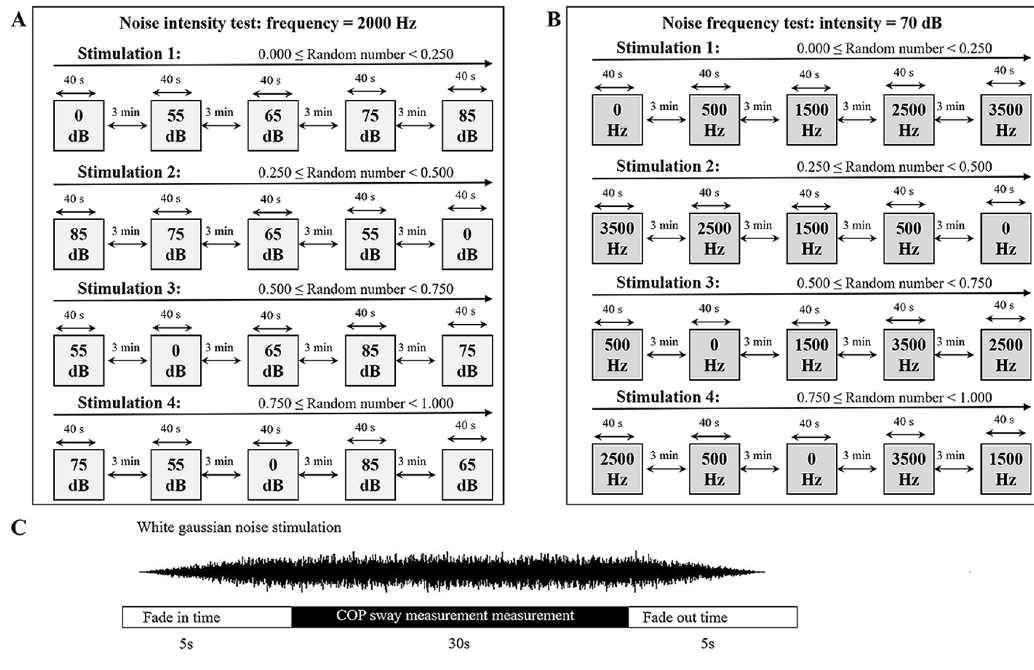
Figure 5. Diagram of the experimental protocol. ( A ) The stimulation blocks in noise intensity test; The stimulation frequency was set to 2000 Hz. Four stimulation blocks with different intensity sequence were previously defined. The stimulation block undergone by a participant was determined by the random number he/she obtained. ( B ) The stimulation blocks in noise frequency test; The stimulation intensity was set to 70 dB. Four stimulation blocks with different frequency sequence were previously defined. The stimulation block undergone by a participant was determined by the random number he/she obtained. ( C ) Data acquisition